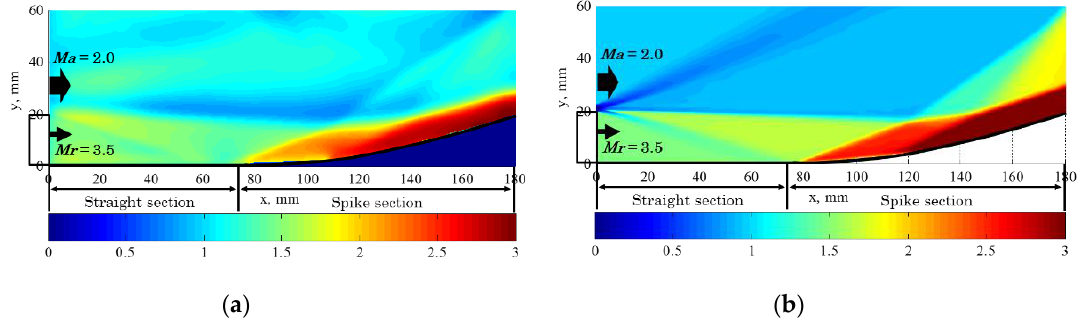
Figure 13. Comparison of qualitative flowfield features between the experiment and CFD for nozzle pressure ratio (NPR) = 49.5 and Mach 2.0 flight condition: ( a ) Density distribution obtained by the experiment using BOS; and ( b ) density distribution obtained by CFD calculated for aerospike nozzle flowfield corresponding to the experimental model. The flow direction is from left to right, and the color bar represents the normalized density based on the density value in the freestream region.